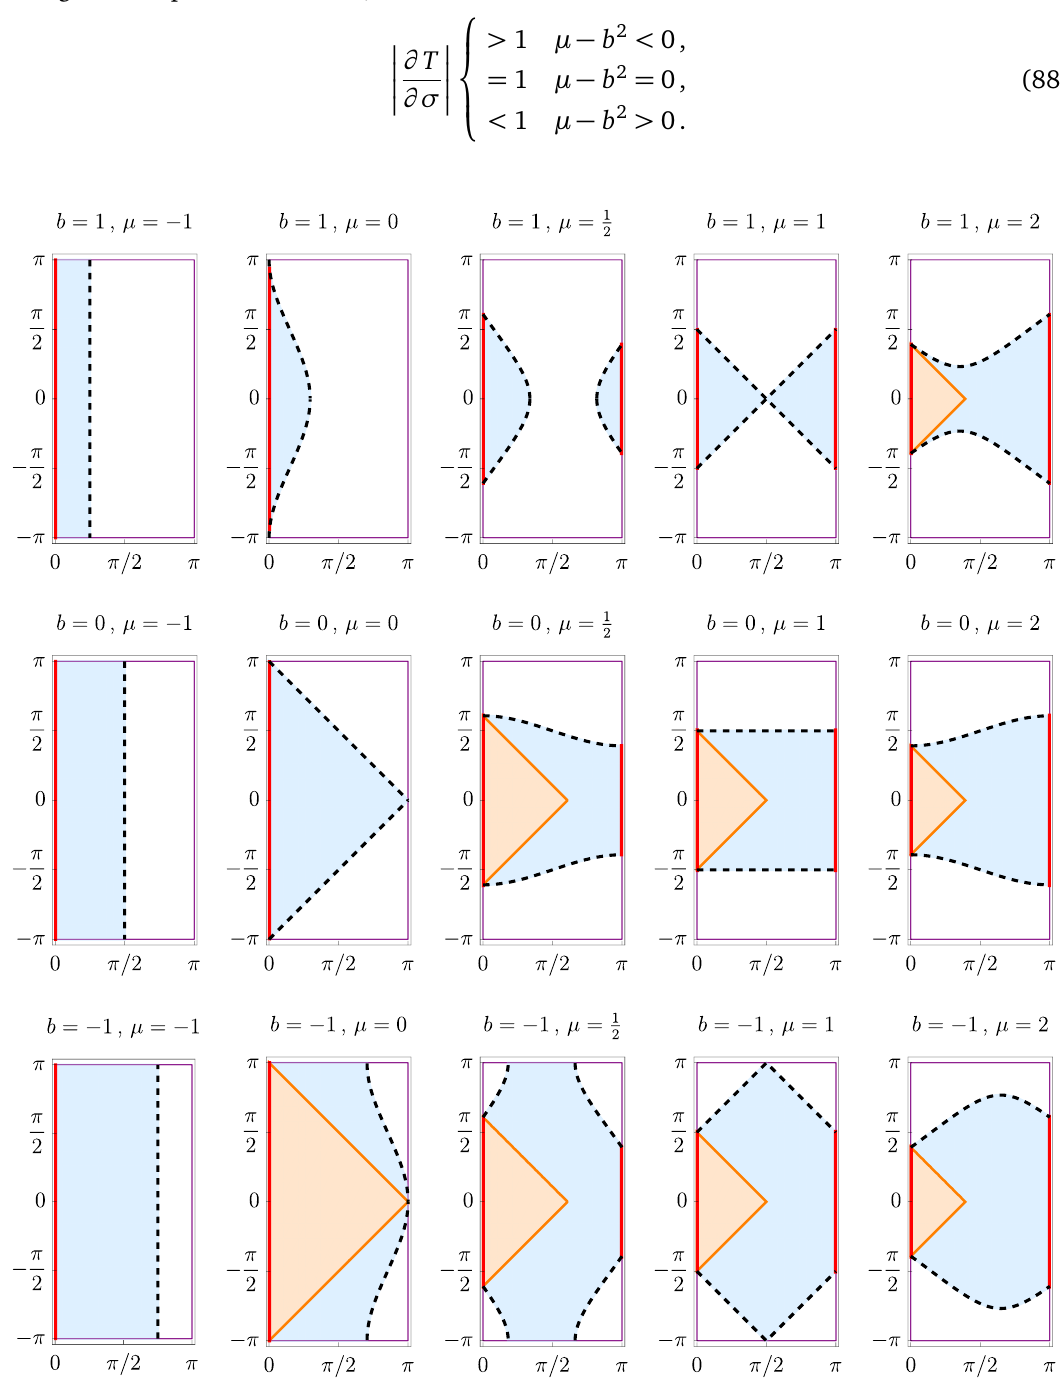
Figure 2: Examples of the region X > 0 in D for models with different values of b and solutions with different values of µ . The region X > 0 is shaded and X = 0 is indicated by a bold dashed black line. The parts of σ = 0 and σ = π in X > 0, where X → ∞ , are indicated with a bold red line. The Schwarzschild-type coordinates introduced in section 2.2 cover the entire region X > 0 (or the part attached to σ = 0, in the case of two disconnected regions) for µ ≤ b 2 when b ≥ 0, and for µ < 0 when b < 0. Otherwise they cover a single horizon wedge, shaded in orange, that includes the X → ∞ boundary at σ = 0. A second horizon wedge attached to σ = π is not